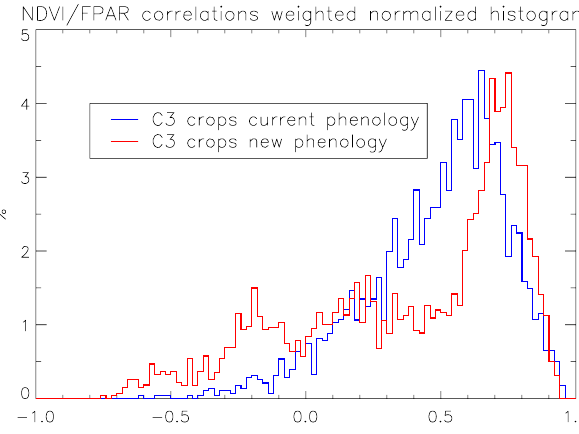
Fig. 6. Weighted normalized histograms of the correlations between the partial NDVI and partial FPAR for the PFT C3 Crops, in blue for the current phenology and in red for the new phenology (bin- size =